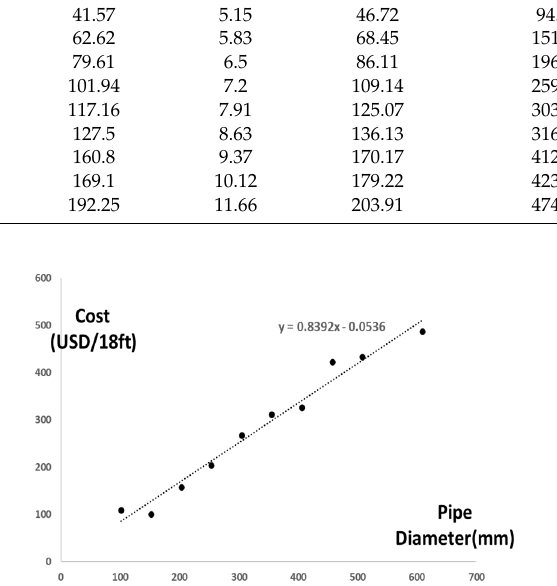
Pipe Diameter (mm)